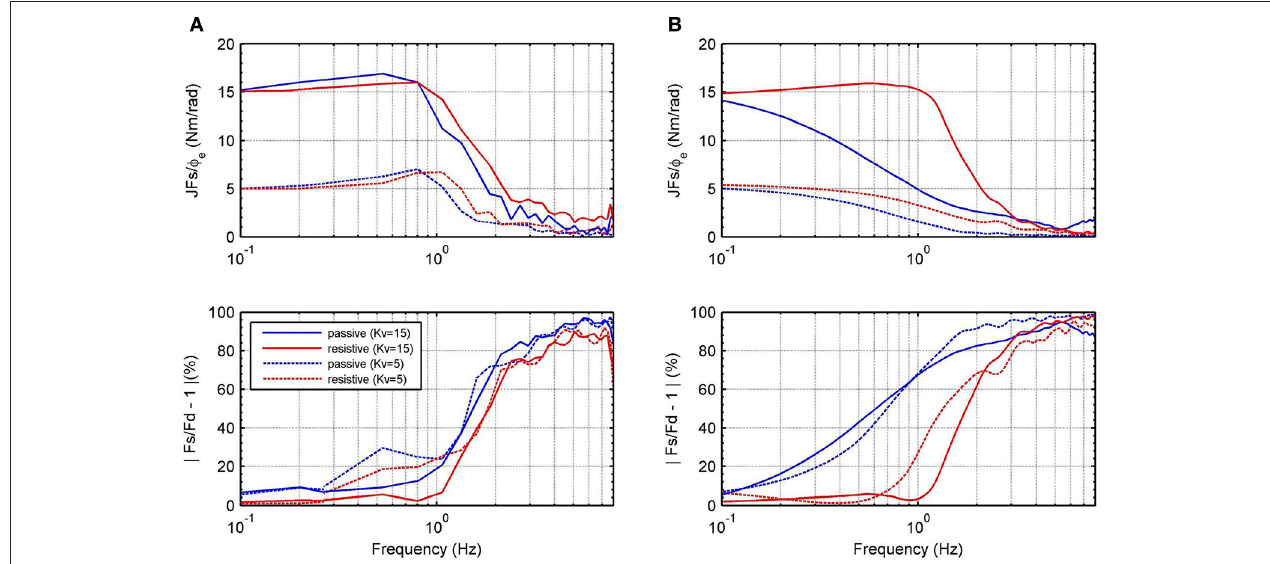
FIGURE 12 | Frequency response for the measured impedance, J F s /φ e , and force error, | F s / F d − 1 | · 100 % , for K v = 15, K v = 5 and B v = 0. (A) Inner recursive RR-DMJLS force control. (B) Inner H ∞ force